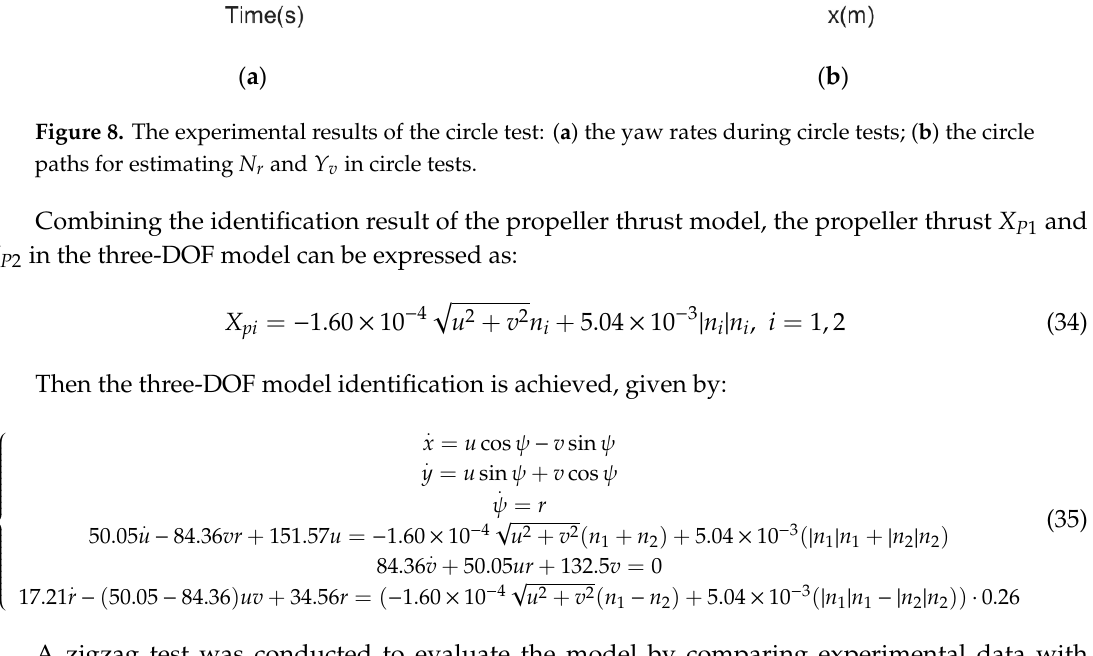
Table 3. Five combinations of motor commands in the zigzag